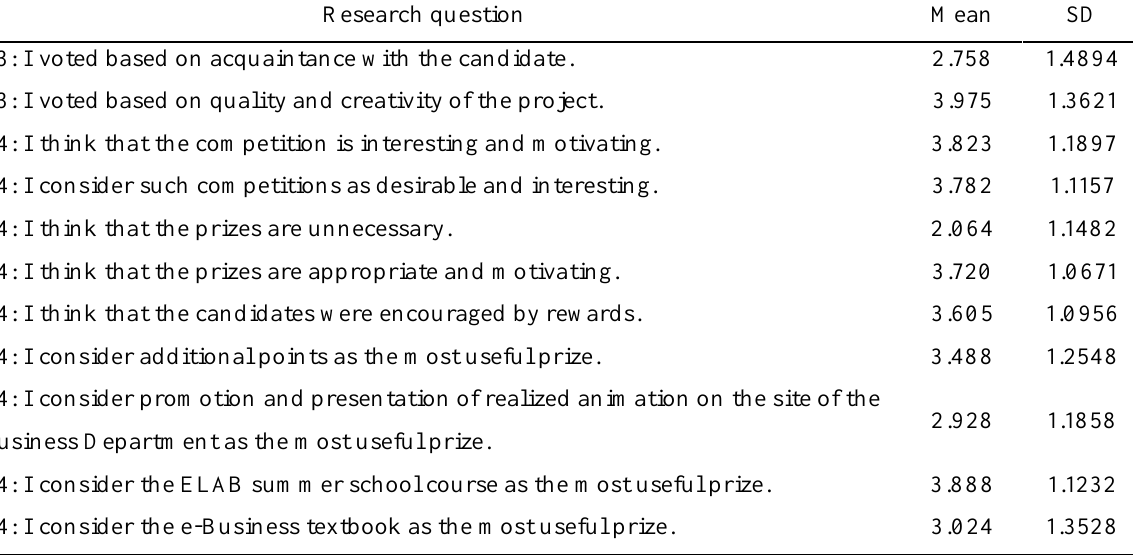
Table 3 Likert-Type Questions Related to Incentives for Participation and Rewards Types Research